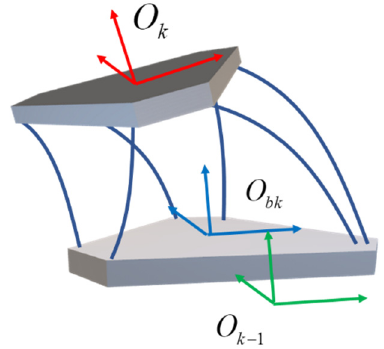
Figure 5. Prototype Design of k-th Flexible Parallel Module.